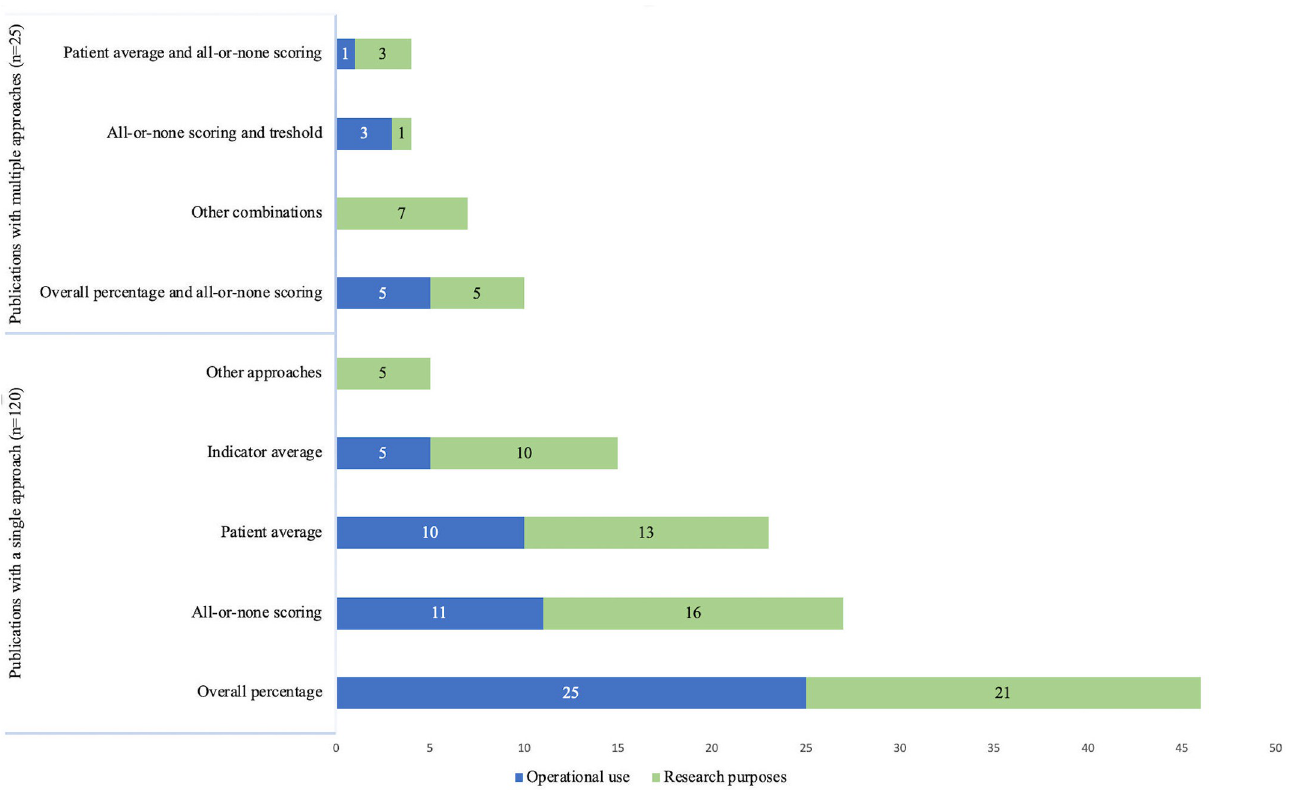
Fig 2. Preferred composite score